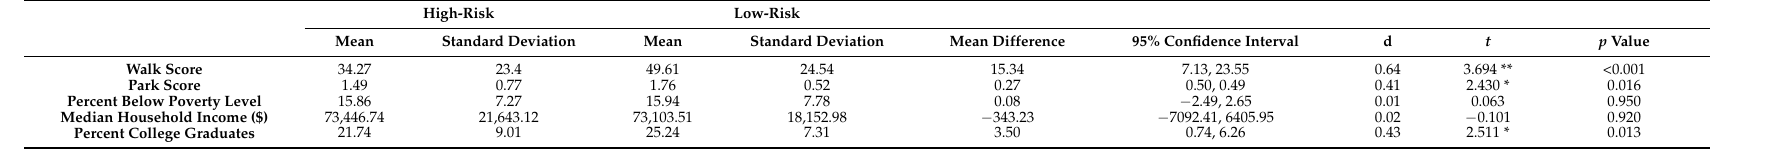
Table 1. Neighborhood characteristics: Comparison between high-risk and low-risk adolescents.